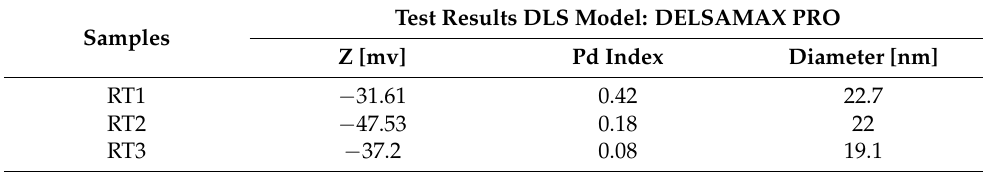
Table 3. DLS results for samples obtained at the room temperature (RT).